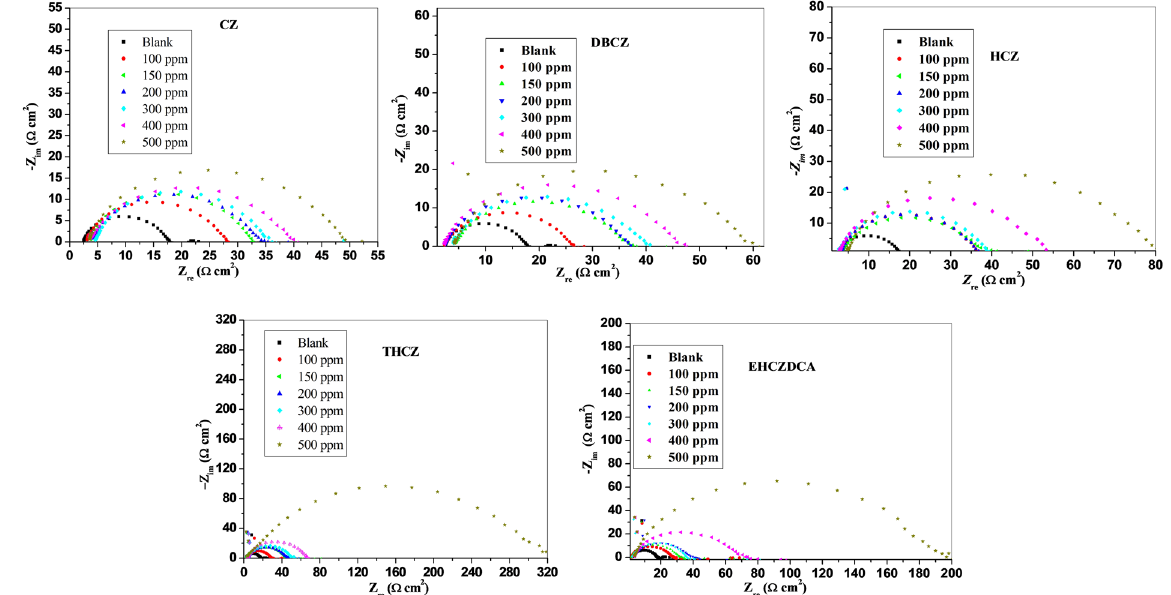
Figure 2. Nyquist plot for mild steel in 1 M HCl in the absence and presence of different concentrations of CZs.